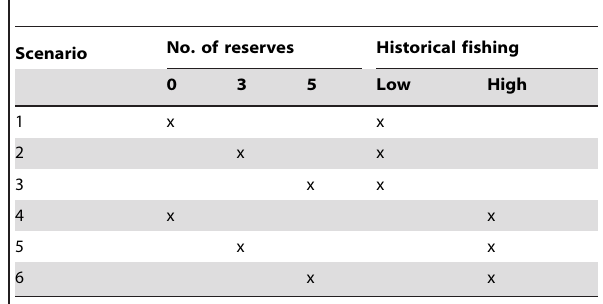
Table 2. Summary of model scenarios. Low historical fishing corresponded to 1976 levels off the NSW coast and high fishing to double this level.